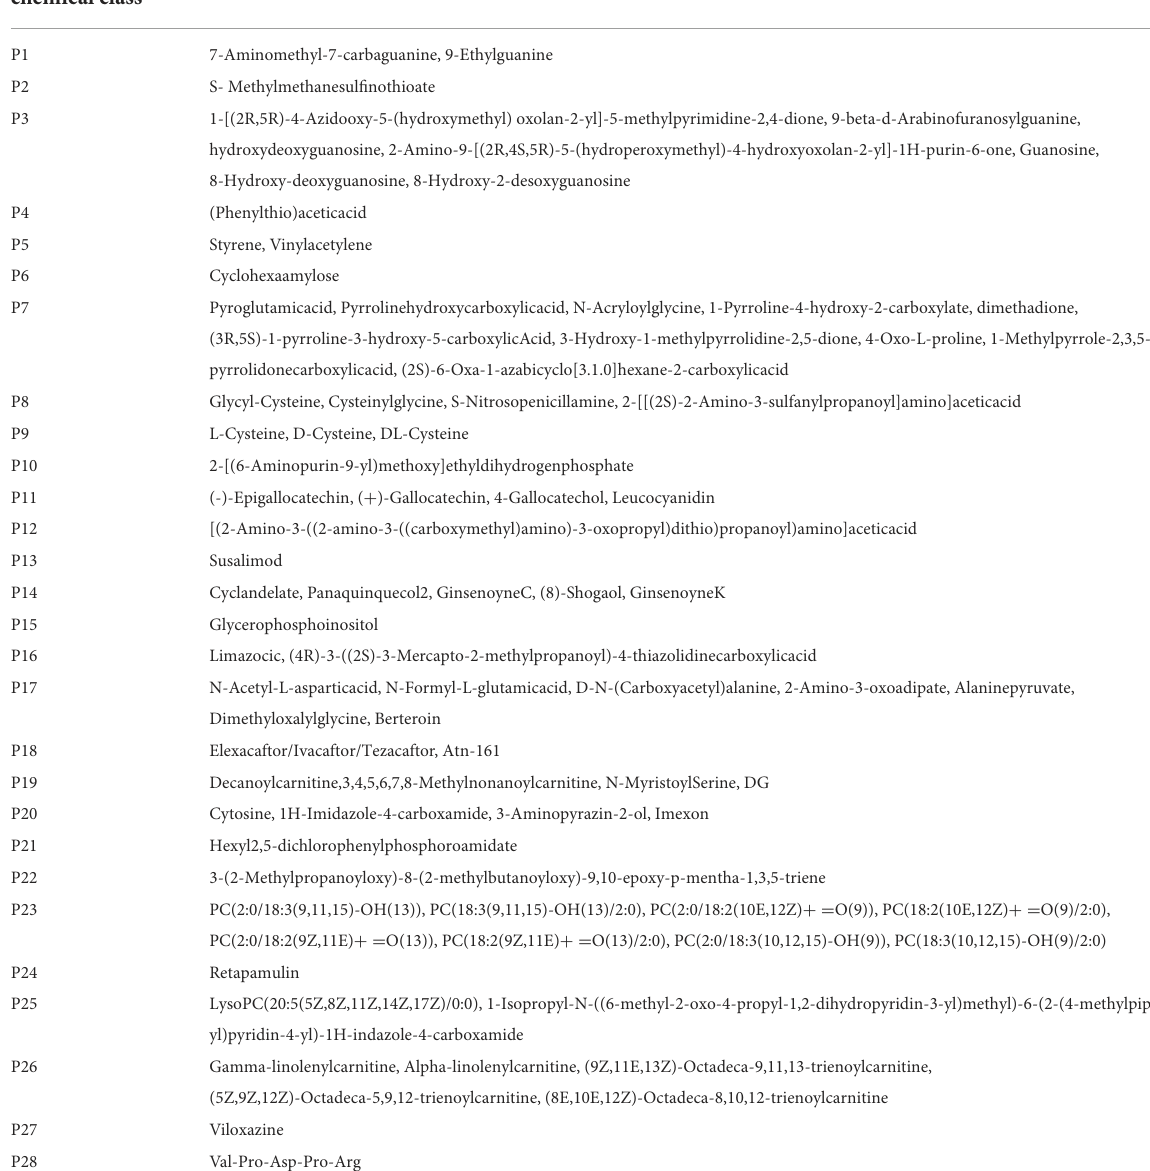
TABLE 3 Identification of mass spectrometry signals in the rat lungs on postnatal day